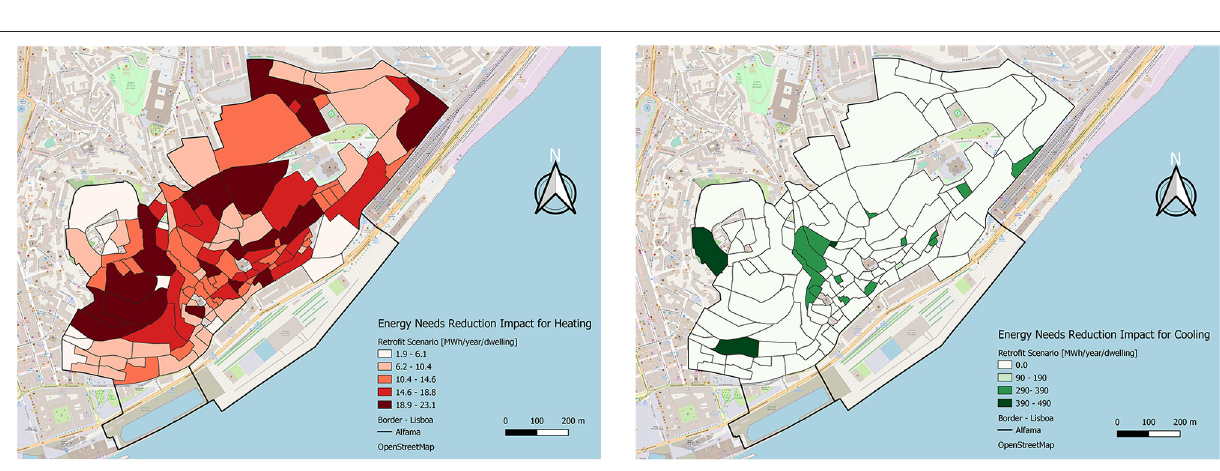
FIGURE 5 | Space heating (left) and cooling (right) energy needs reduction impact per average dwelling in